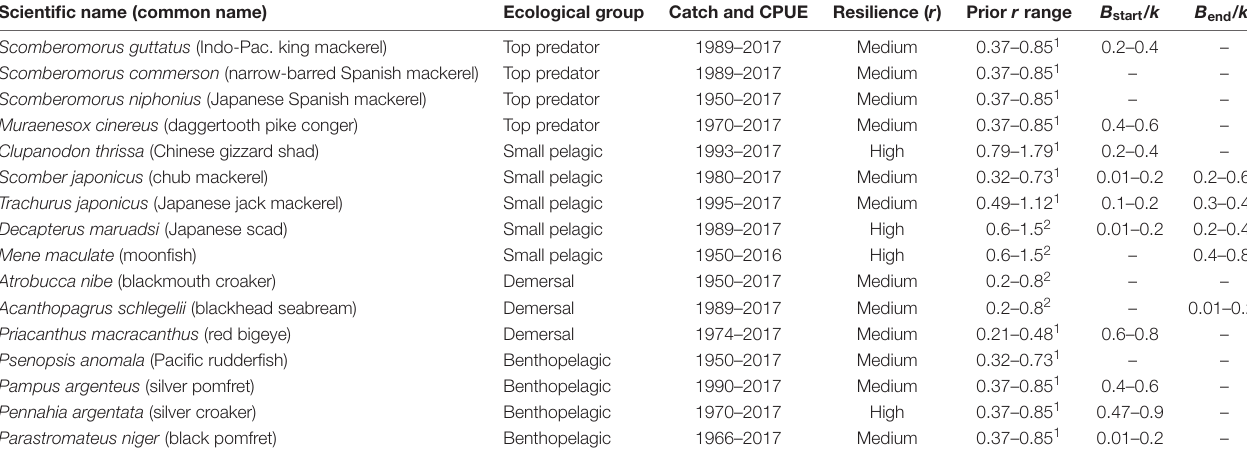
TABLE 1 | Basic data information on key species in the coastal and offshore waters of Taiwan, with “resilience” levels from FishBase.